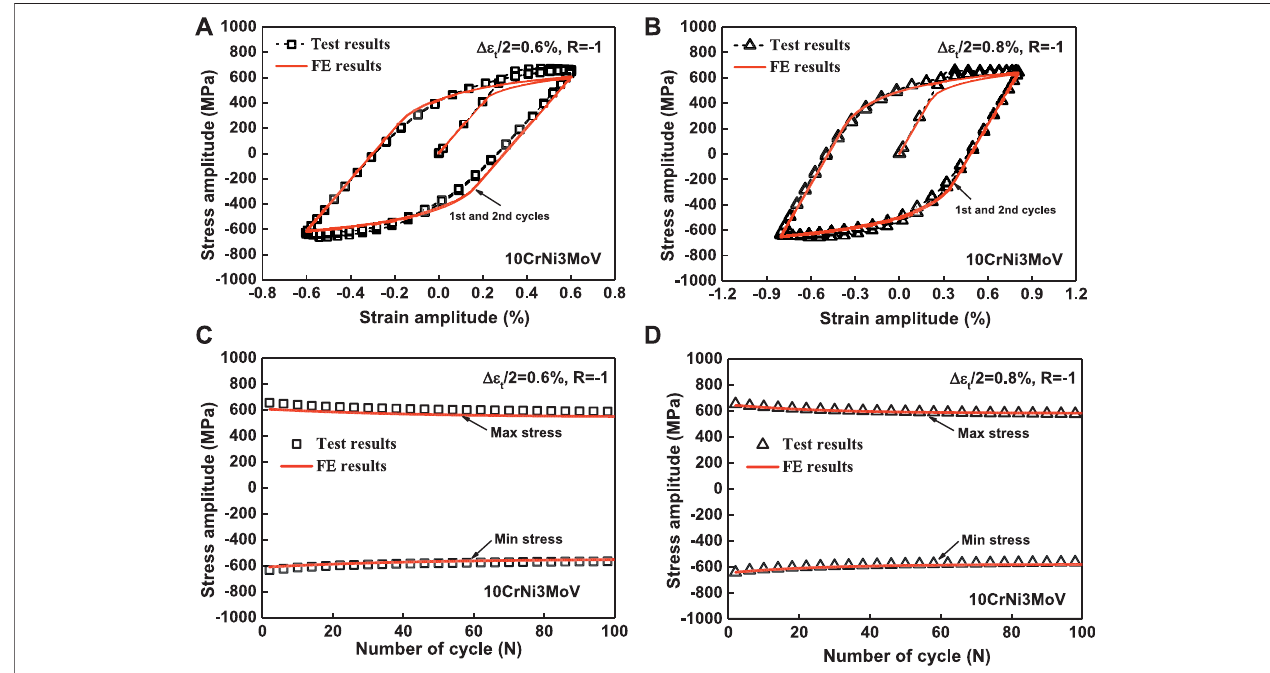
FIGURE 6 | Experimental and simulation comparisons of the fi rst and second cyclic hysteresis loops and max – min stress evolution for 10CrNi3MoV steel. (A) Hysteresisloopsunder Δ ε t /2 (cid:1) 0.6%, (B) hysteresisloopsunder Δ ε t /2 (cid:1) 0.8%, (C) max – minstressevolutionunder Δ ε t /2 (cid:1) 0.6%,and (D) max – minstressevolutionunder Δ ε (cid:1) t /2